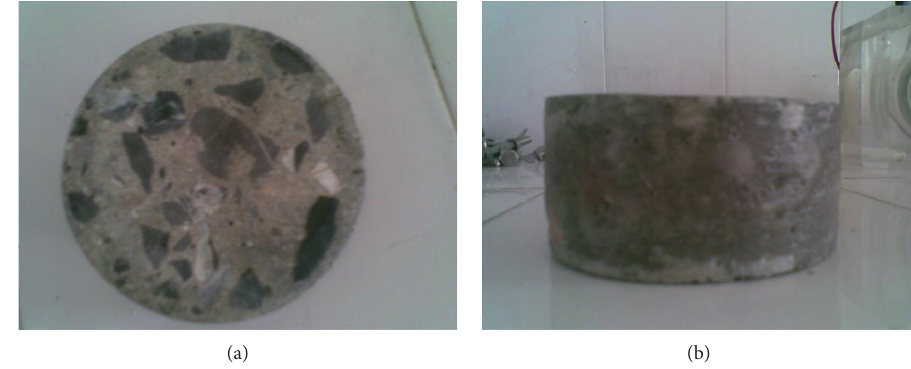
Figure 4: The antichlorine ion permeation test block.